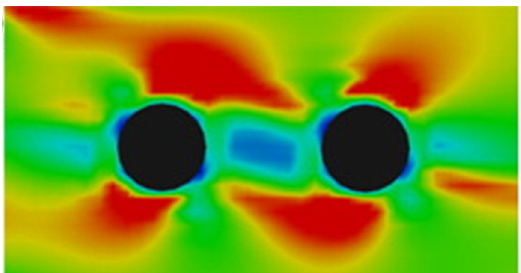
Figure 6. Simulation of a sheared particle pair in a viscoelastic fluid. The stress in the fluid favors chaining the direction of shear. Reprinted with permission from [196], copyright 2014 Elsevier.